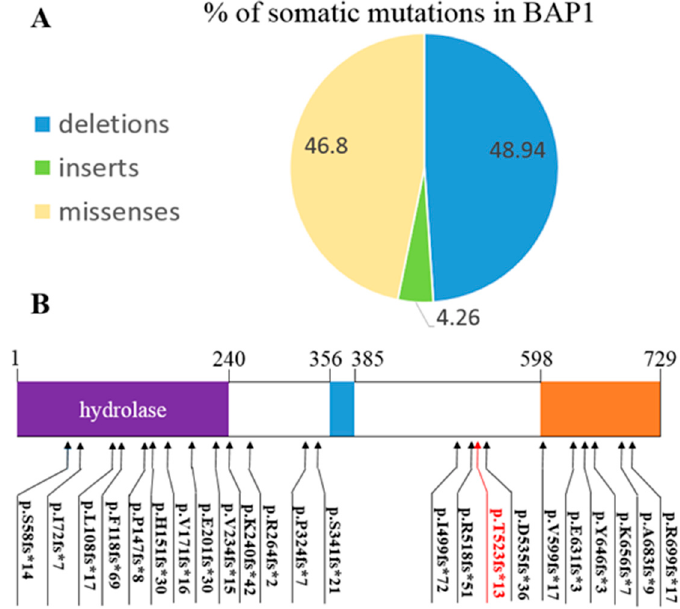
Figure 5. ( A ) Percentages of somatic mutations in BAP1 gene: missense point mutations, 46.8%; deletions, 48.94%; and inserts, 4.26%; ( B ) Mutations’ position along the Bap1 protein after frameshift (22 frameshift mutations of COSMIC in black, novel frameshift in red).